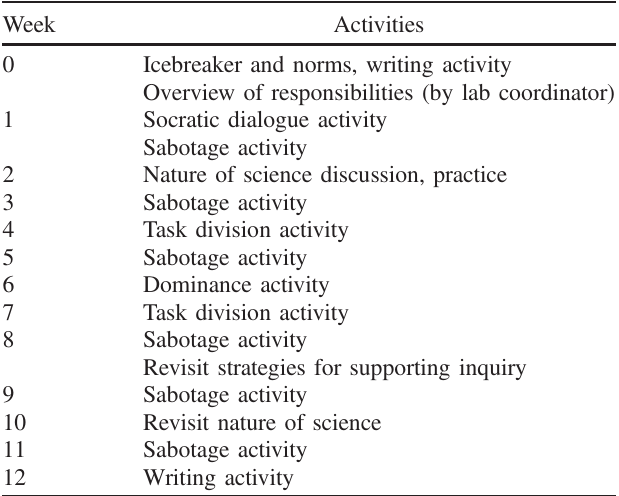
TABLE II. Program of lab TA meeting activities during one semester. Each meeting begins with a reflection activity and a brief apparatus or experiment briefing. Some activities are repeated with the new context of a different lab because it takes time for TAs to develop